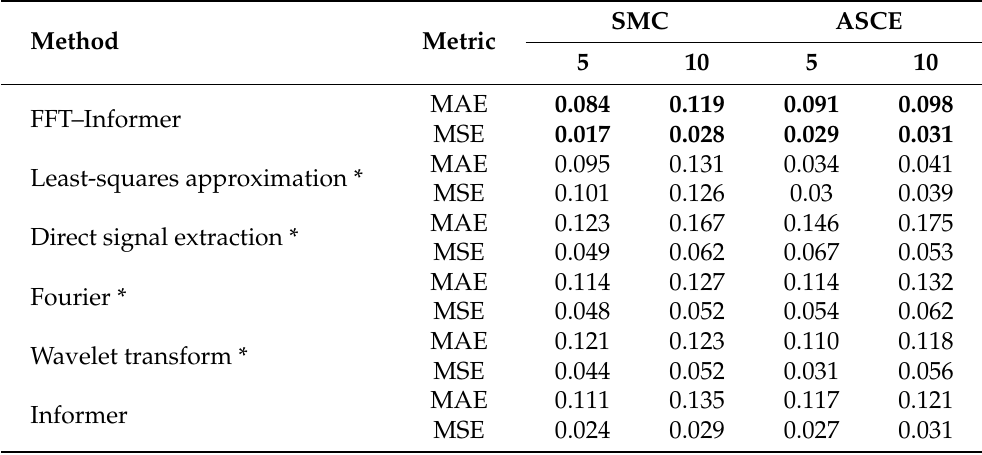
Table 3. Comparison of the prediction results of the combination of each feature extraction method for the long-term forecasting algorithm and Informer. (* represents the combination with Informer model. 5 and 10 represents five and ten feature windows. Bold value is the minimum value).